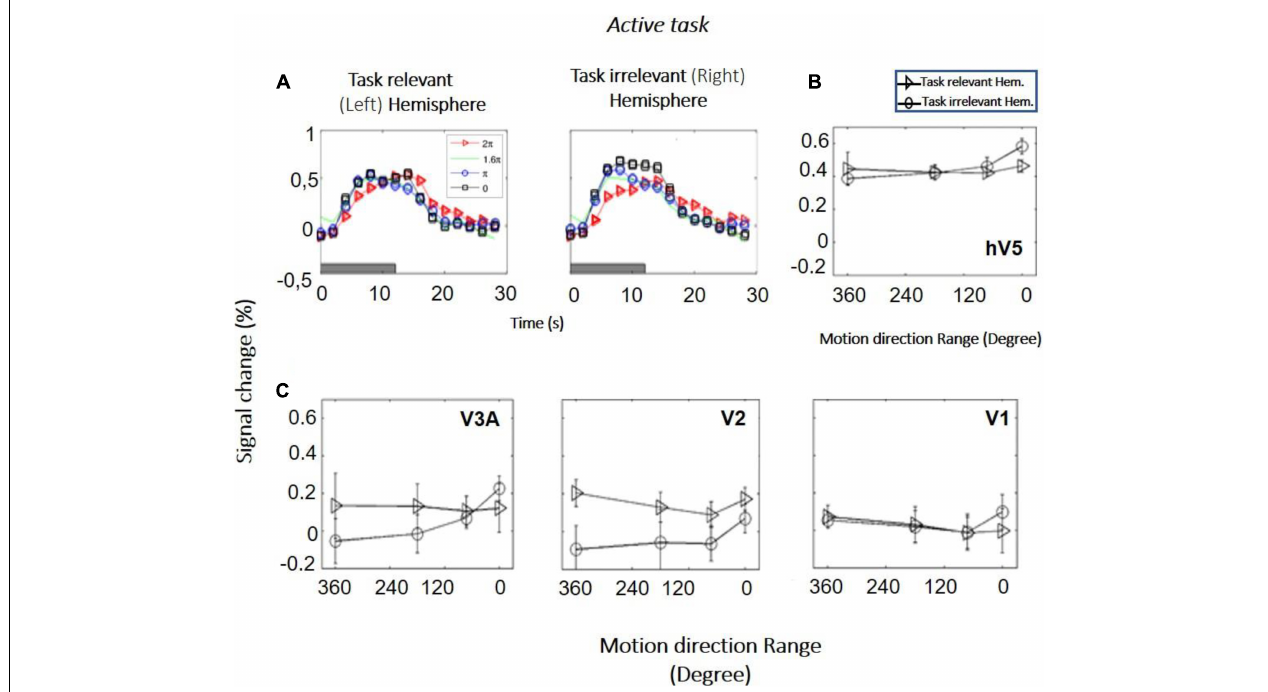
FIGURE 6 | BOLD activity as a function of coherence in the task-relevant versus the task-irrelevant hemisphere (study B). (A) BOLD signal change in hV5/MT+ of the task-relevant (left) versus the task-irrelevant (right) hemisphere of one subject. (B) Average BOLD signal change in the area hV5/MT+ of the task-relevant (left, triangle) versus the task-irrelevant (right, circle) hemisphere across 6 subjects. (C) Same as B for areas V3A, V2, and V1. Error bars indicate the standard error of the mean across